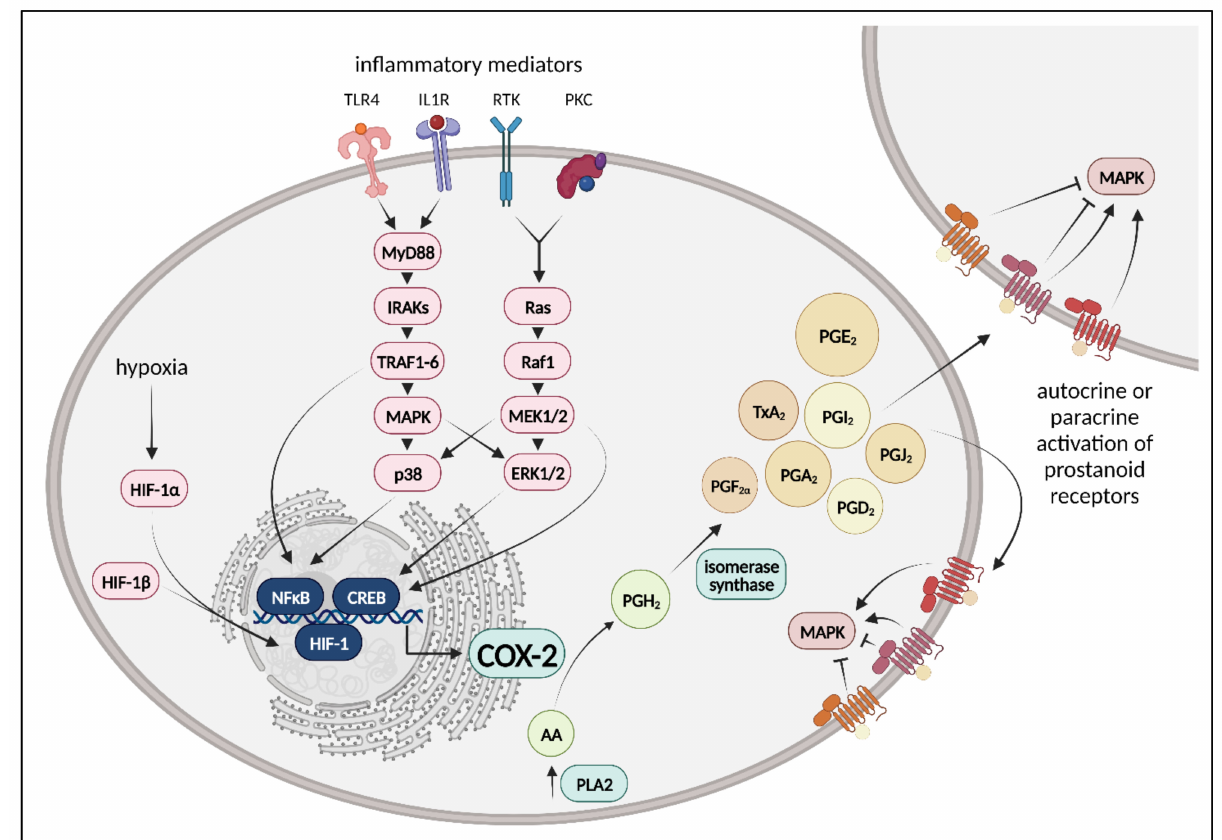
Figure 1. Schematic depiction of selected cyclooxygenase-2 (COX-2) signaling pathways. Ligand bind- ing of inflammatory mediators to their receptors, such as pattern recognition receptors (Toll-like receptor 4, TLR-4), cytokine receptors (interleukine-1 receptor, IL1R), tyrosine kinase receptors (RTK) or protein kinase C (PKC) activates inflammatory signaling via myloid differentiation primary response gene 88 (MyD88)- or rat sarcoma (Ras)-dependent activation of several mitogen-activated protein kinases (MAPK), such as extracellular signal-related kinases 1/2 (ERK1/2) or p38. Thereby, activation of proin- flammatory transcription factor nuclear factor κ B (NF- κ B) or cAMP response element-binding protein (CREB) is mediated. Further, hypoxia induces the activation of hypoxia-inducible factor-1 α (HIF-1 α ) leading to the transcription of HIF-regulated genes. COX-2 is regulated by NF- κ B, CREB, or HIF-1 α , amongst others; therefore, it is expressed under proinflammatory or hypoxic conditions. COX-2 metab- olizes arachidonic acid (AA), which is mobilized from the sn-2 position of membrane phospholipids through phospholipase A 2 (PLA 2 ) in a two-step reaction into prostaglandin H 2 (PGH 2 ), a substrate for several downstream isomerases and synthases in the generation of prostanoids: prostaglandins D 2 (PGD 2 ), E 2 (PGE 2 ), F 2 α (PGF 2 α ), A 2 (PGA 2 ), and J 2 (PGJ 2 ), thromboxane A 2 (TXA 2 ) and prostacyclin (PGI 2 ). The size of the prostanoids shown corresponds to their relevance for inflammatory processes in the lung endothelium. Prostanoids act in an autocrine or paracrine manner by binding specific prostanoid receptors, which are class A, rhodopsin-like G protein-coupled receptors. Prostanoid re- ceptors induce both classical G protein-dependent pathways and G protein-independent pathways, whereas downstream signaling is shaped by the prostanoid ligand and either activates or inhibits MAPK signaling. Mitogen-activated protein kinase kinase 1/2, MEK1/2; interleukine-1 receptor associated kinases, IRAKs; rapidly accelerated fibrosarcoma 1, Raf1; tumor necrosis factor receptor associated factor 1, TRAF1-6. Created with